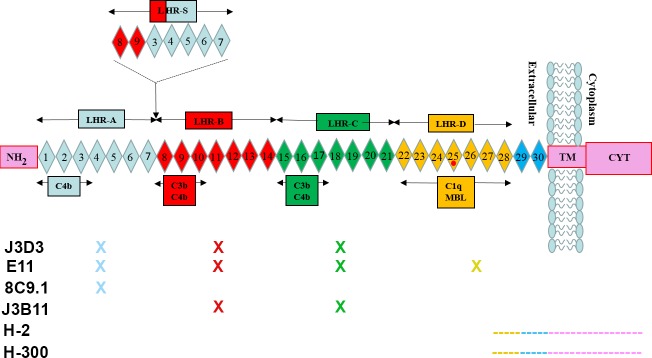
Representation of CR1 structure, ligand binding sites and location of antibody epitopes.CYT: cytoplasmic domain, TM: transmembrane domain. Red dot indicates location of rs4844609 (Ser1610Thr). Diagram modified from[16]; Antibody reactivity modified from[17].